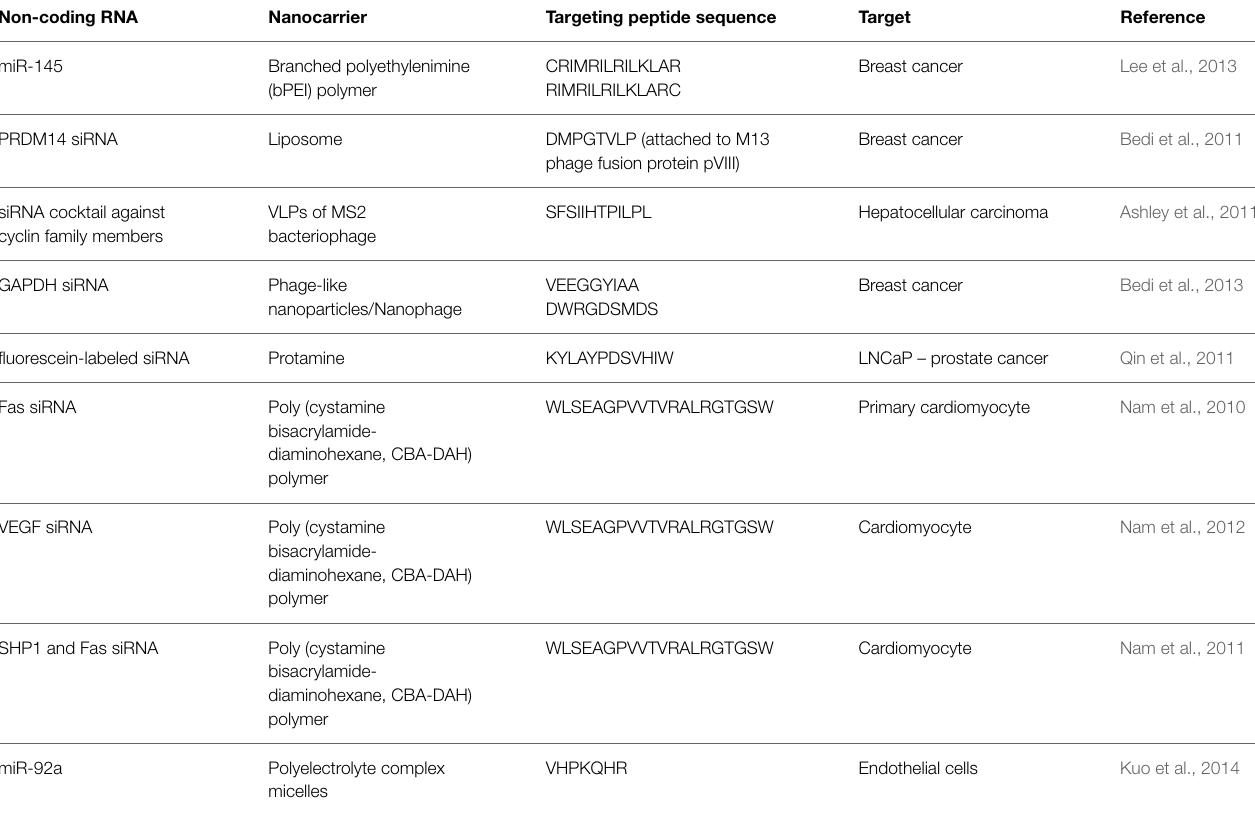
TABLE 1 | Studies in which peptides obtained through screening of phage display libraries have been used to functionalize the surface of nanocarriers for targeted delivery of miRNA and siRNA. Non-coding